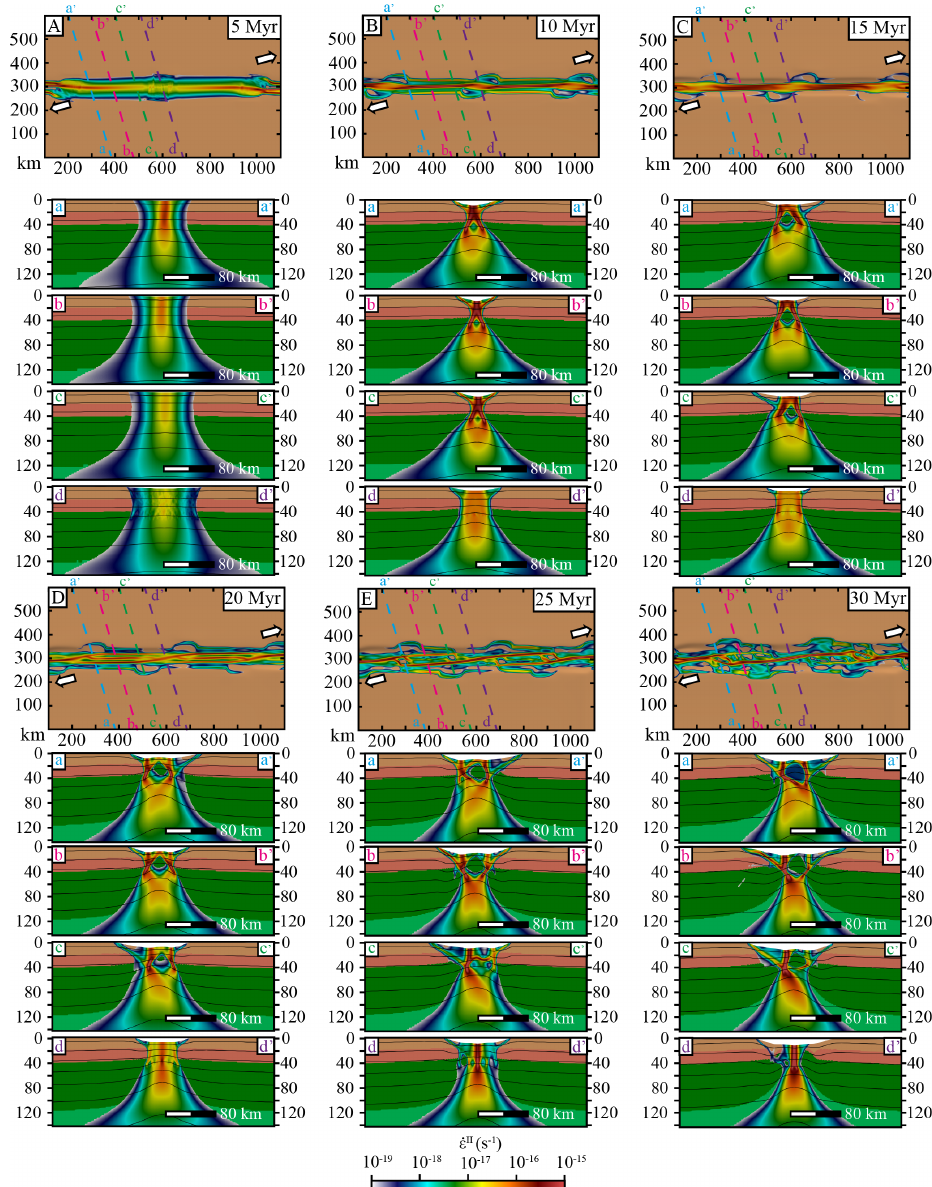
Figure 8. Model 3, strong lower crust, α = 15 ◦ . Map views and cross sections of simulated lithologies and second invariant of the strain rate tensor (Eq.